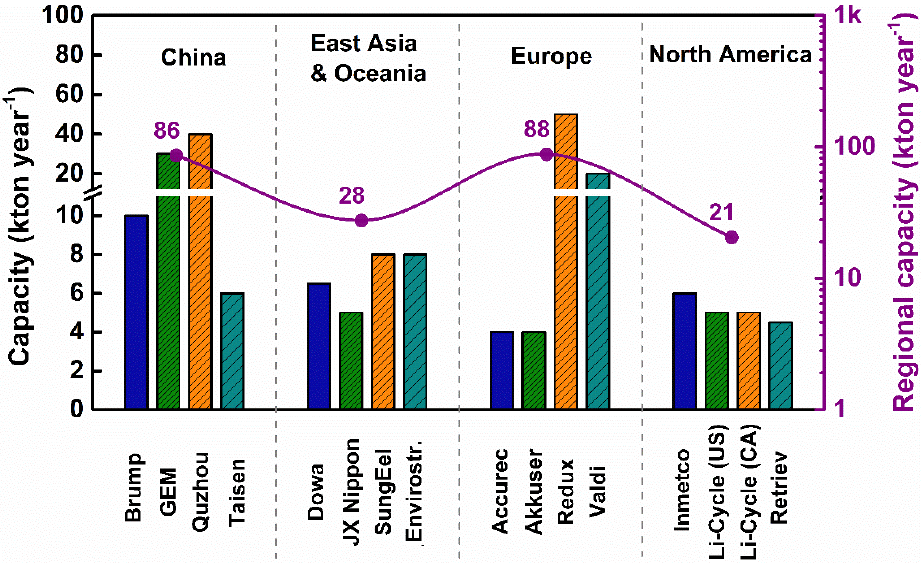
Figure 4. Annual capacity shares of currently available industrial LIB recycling processes (players with a production < 3000 kT year − 1 are not shown) and the summarized production values per region (data from